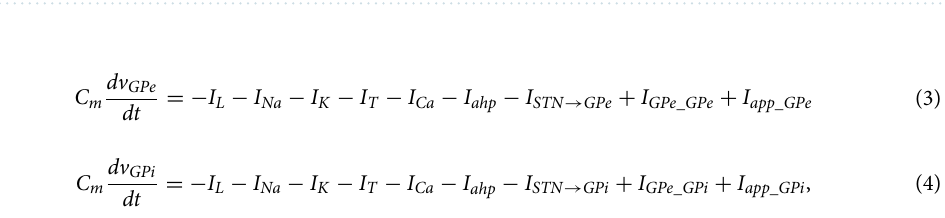
Table 1. The net bias applied currents (uA/cm 2 ) to the different BG populations for the healthiness and PD